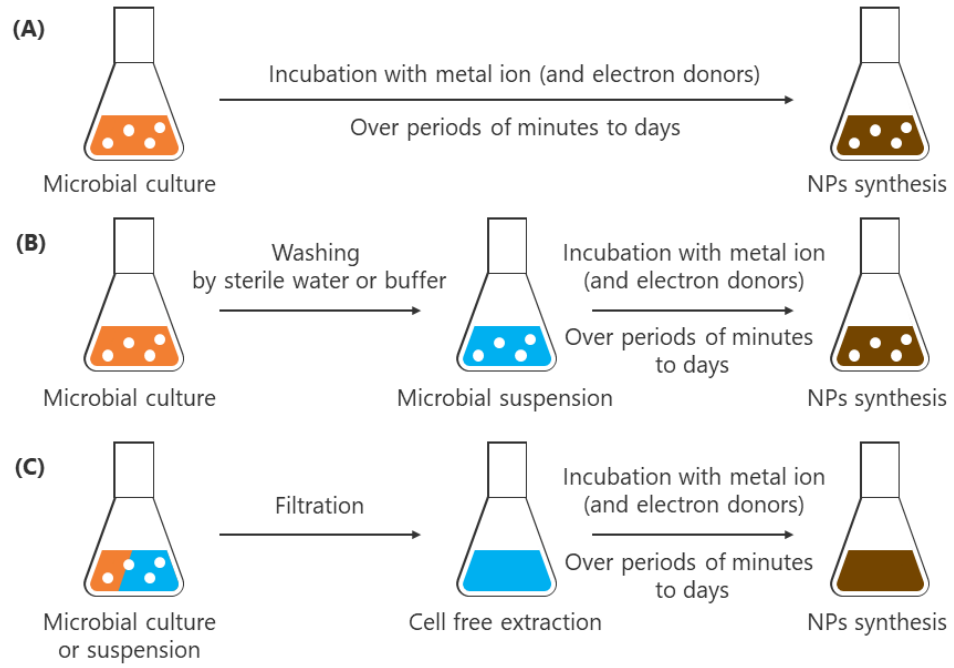
Figure 4. Scheme of metal NPs synthesis by microorganisms, ( A ) NPs synthesis by microbial culture ( B ) NPs synthesis by washed microbial culture, and ( C ) NPs synthesis by cell free extracts (CFE). Various techniques are used to study the properties of metal